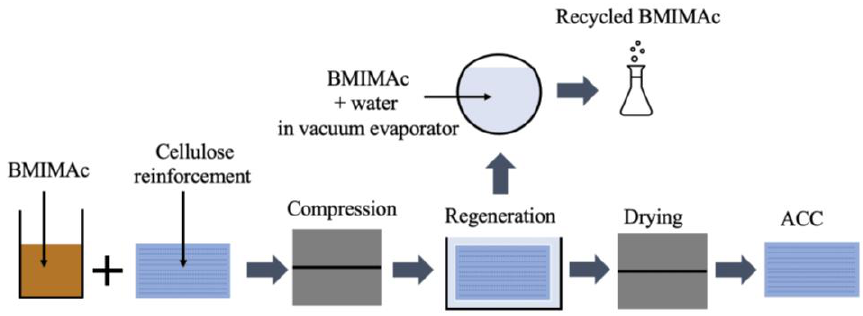
Figure 3. Illustration of the method for the one-step method.